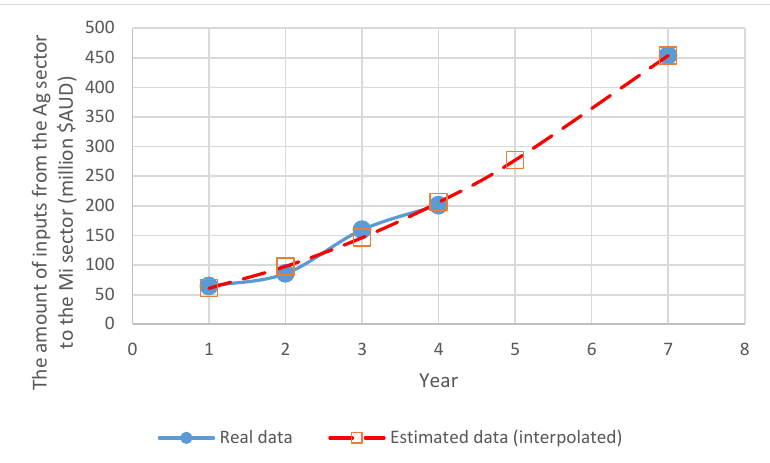
Figure 3. Inputs from the AG sector to the MI sector (quadratic polynomial equation). Agriculture, forestry, and fishing = AG; Mining = MI.